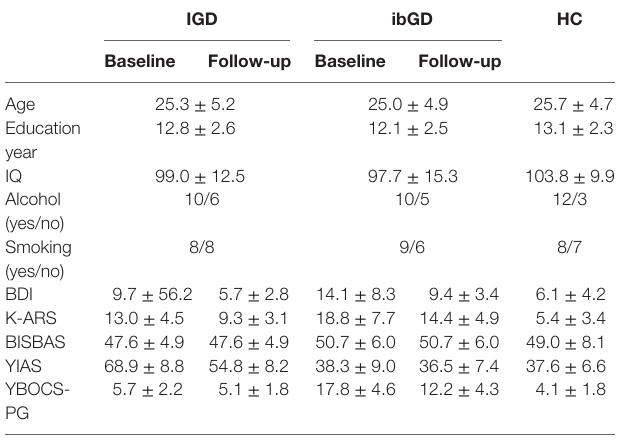
FigUre 2 | Changes in brain functional connectivity after 12 weeks of bupropion treatment. Red line: increased functional connectivity (FC), blue line: decreased FC, In the IGD group at baseline, the functional correlation between the middle frontal gyrus (MPFC) and left inferior prefrontal cortex (IFGLt) ( t = 3.39, FDRq = 0.0026), left dorsolateral prefrontal cortex (DLPFCLt) and right lateral parietal cortex (LPRt) ( t = 3.34, FDRq = 0.0030), and left posterior parietal cortex (PPCLt) and IFGRt ( t = 3.67, FDRq = 0.0013). At 12 weeks, the functional correlation between the posterior cingulate cortex (PCC) and LPRt ( t = − 3.26, FDRq = 0.0017), LPRt and PPCRt ( t = − 3.16, FDRq = 0.0023), and LPRt and PPCLt ( t = − 3.42, FDRq = 0.0012). In ibGD group at baseline, the functional correlation between the PCC and LPLt ( t = − 3.36, FDRq = 0.0014), PCC and LPRt ( t = − 3.26, FDRq = 0.0027). At 12 weeks, the functional correlation between the PCC and PPCLt ( t = − 3.23, FDRq = 0.0031), PCC and PPCRt ( t = − 3.25, FDRq = 0.0031). The functional correlation between the PPCLt and PPCRt ( t = 3.12, FDRq = 0.0042). In the IGD vs ibGD comparison (repeated measure analysis of variance), the ibGD group showed increased FC between IFGRt and PPCLt ( F = 3.67, p = 0.0013), compared with IGD group.